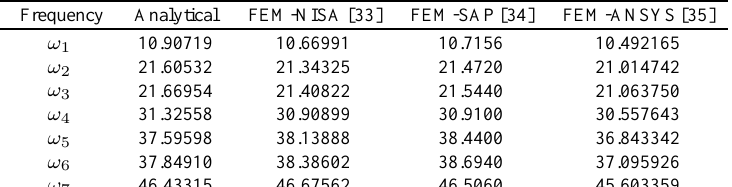
Table 2 Comparison of normalized frequencies between analytical and FEM solution for panels